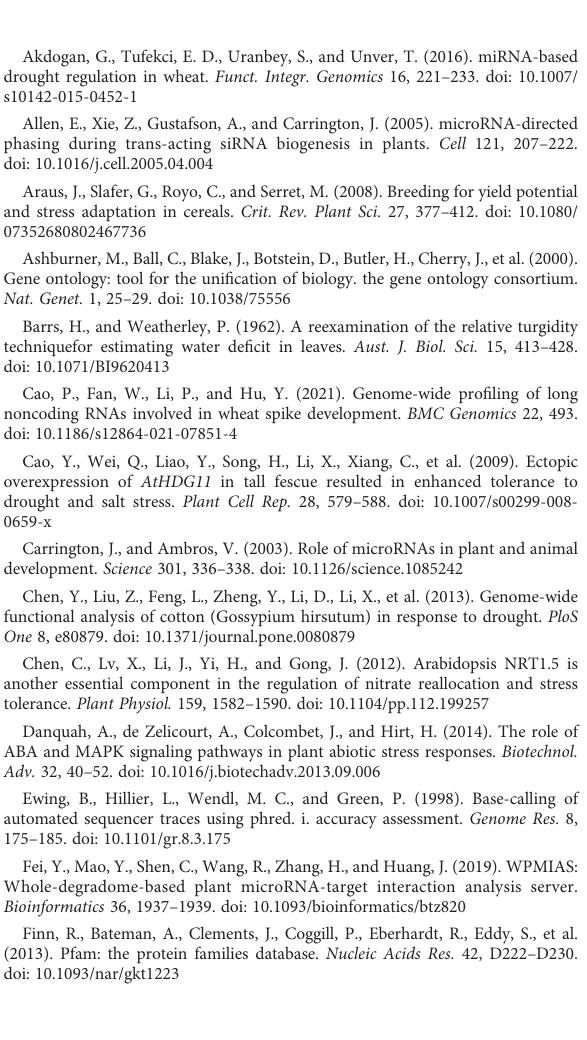
SUPPLEMENTARY FIGURE 2 Statistical plot of lncRNAs. SUPPLEMENTARY FIGURE 3 Length distribution of miRNAs. SUPPLEMENTARY FIGURE 4 Validation of the expression patterns of randomly selected DEGs by qRT- PCR.ThecolumnrepresentstherelativeexpressionlevelofqRT-PCR,and the broken line represents the log 2 (fold change) of RNA-Seq. Positive values on the y axis represent up-regulation of genes, and negative values represent down-regulation of genes. SUPPLEMENTARY FIGURE 5 GO enrichment analysis of drought resistance-related DEGs. SUPPLEMENTARY FIGURE 6 KEGGenrichmentanalysisof droughtresistance-related DEGs. (A) Scatter plot of KEGG pathway enrichment analysis. Each circle in the fi gure represents a KEGG pathway, the ordinate represents the name of the